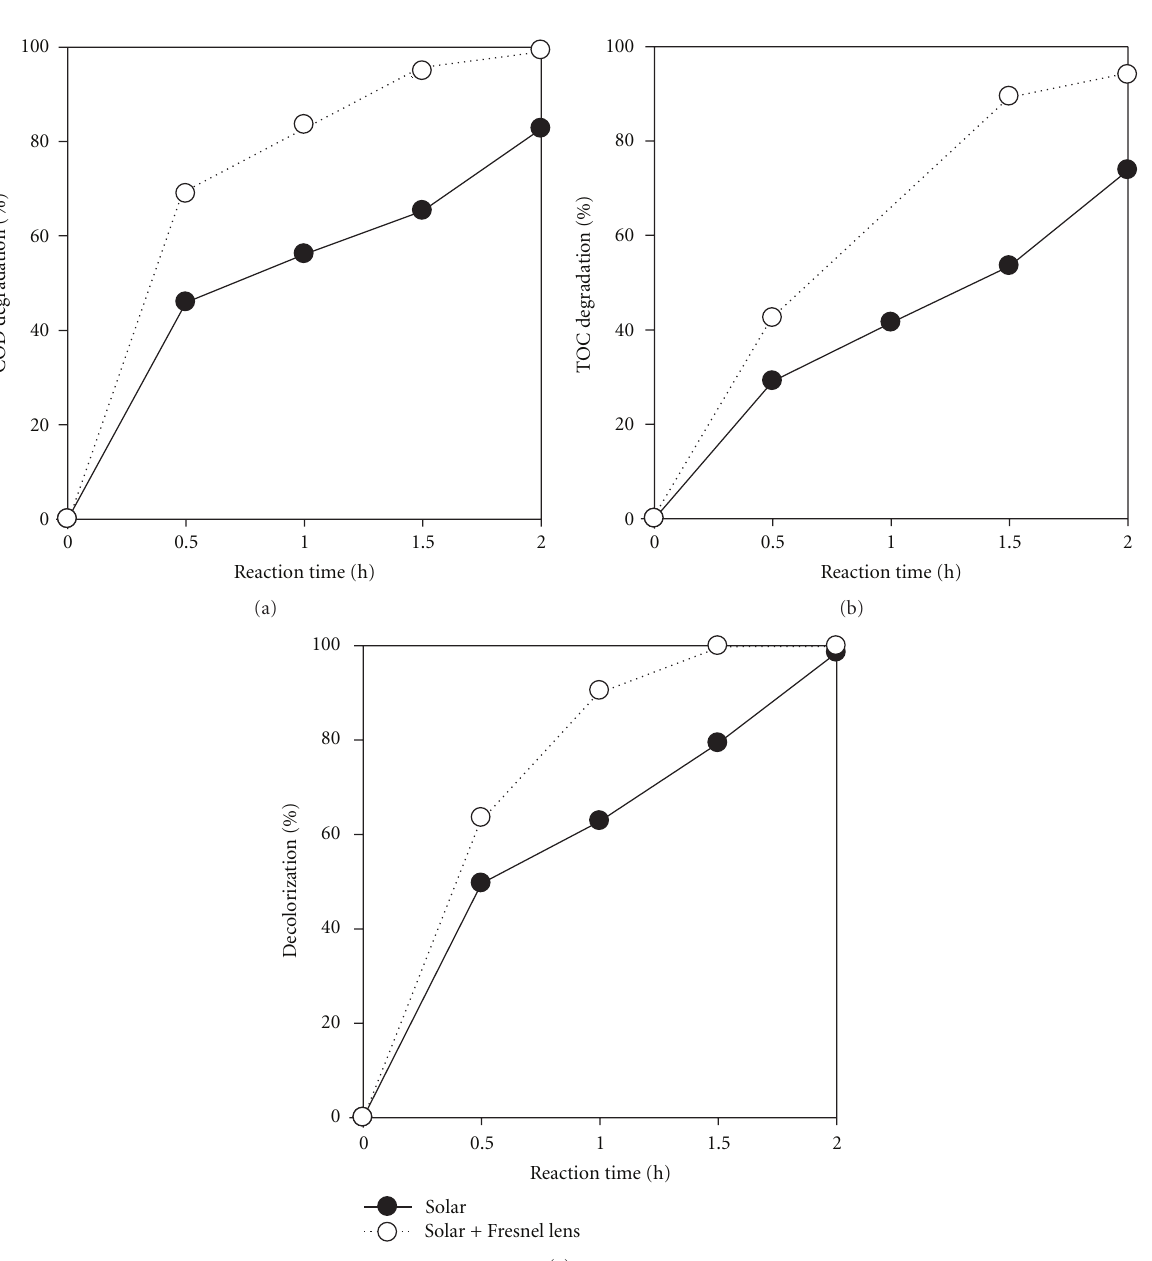
Figure 3: E ff ect of Fresnel lens on the degradation e ffi ciency of AO10 dye wastewater in summer season